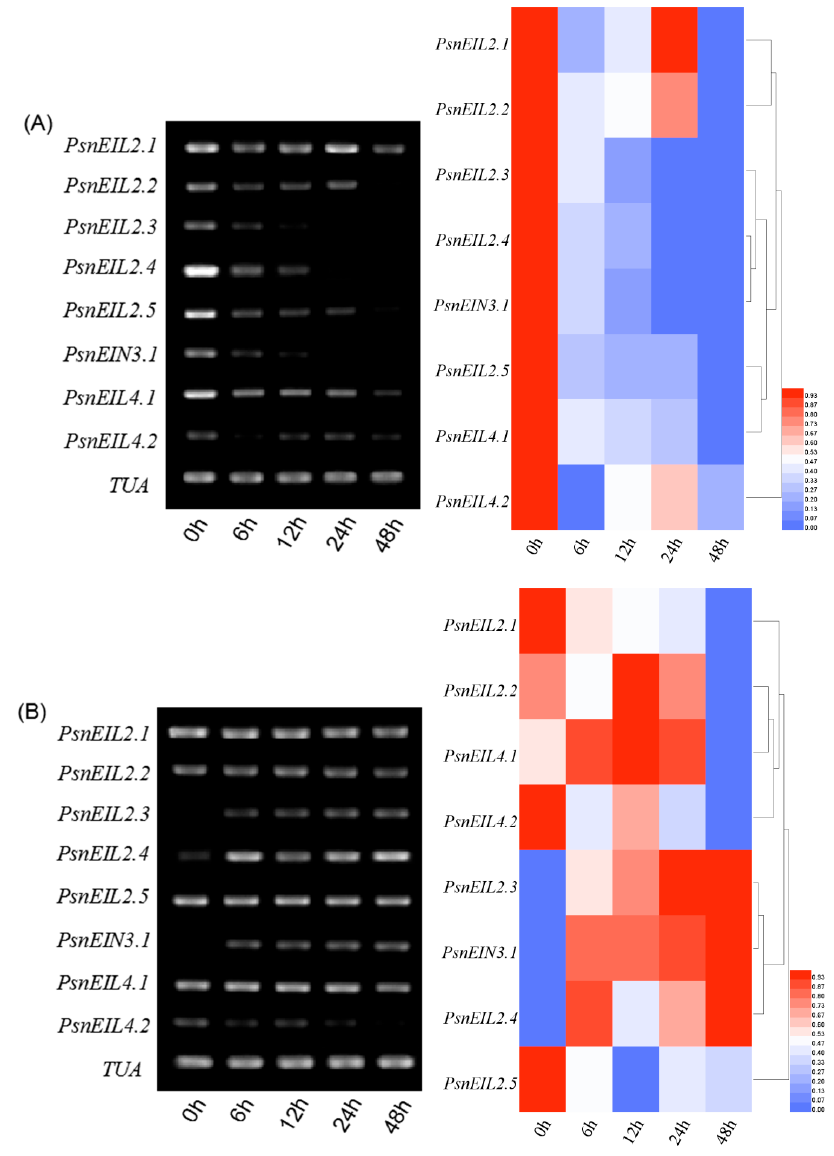
Figure 12. EIN3/EIL gene expression patterns of Populus × xiaohei under CdCl 2 stress. ( A ) Root. ( B ) Leaf.